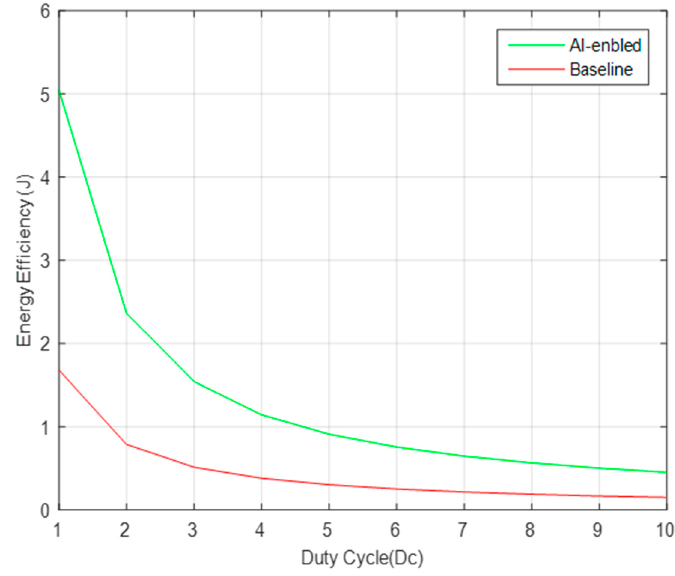
Figure 2. Energy Efficiency during compressive sensing in IoT devices.